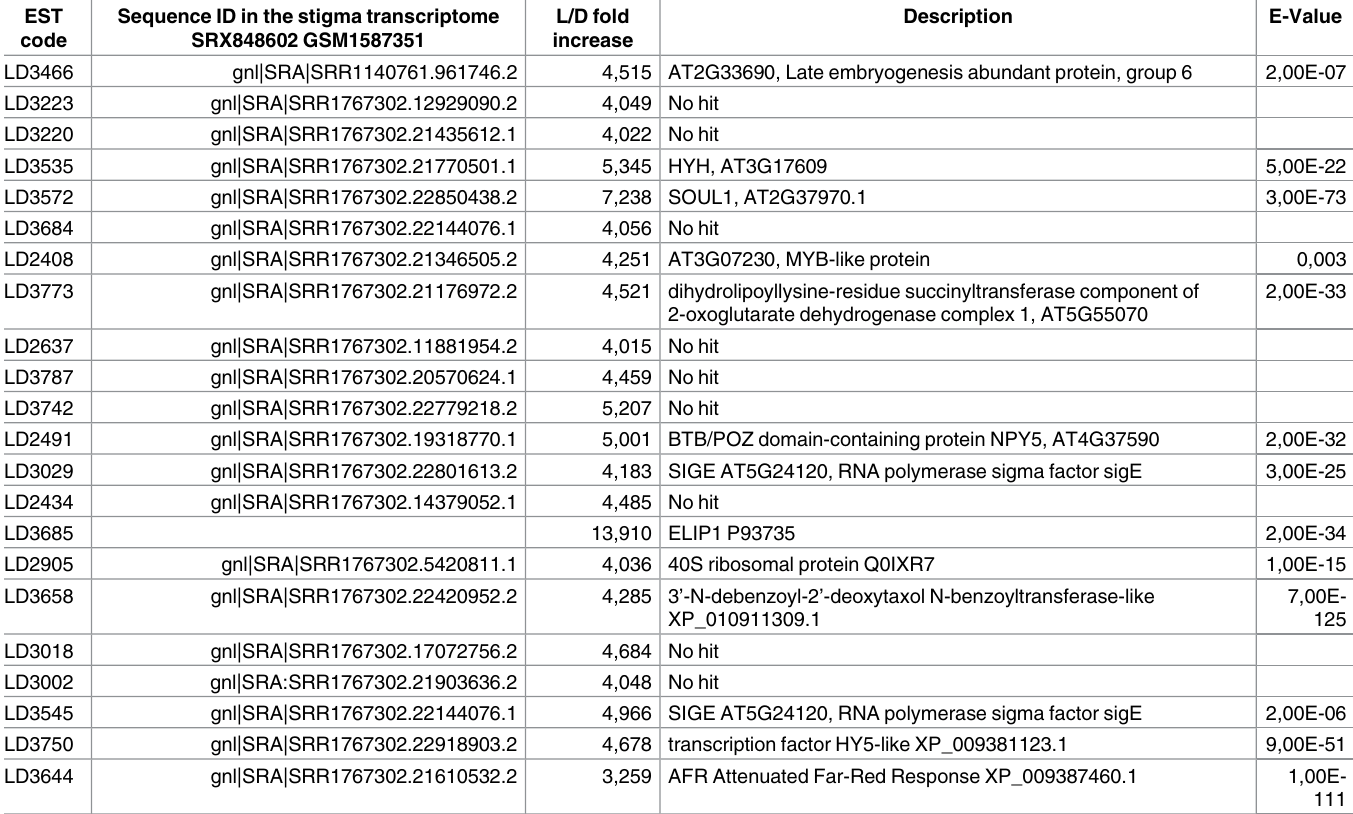
Table 1. EST clones up-regulated by light in red saffron